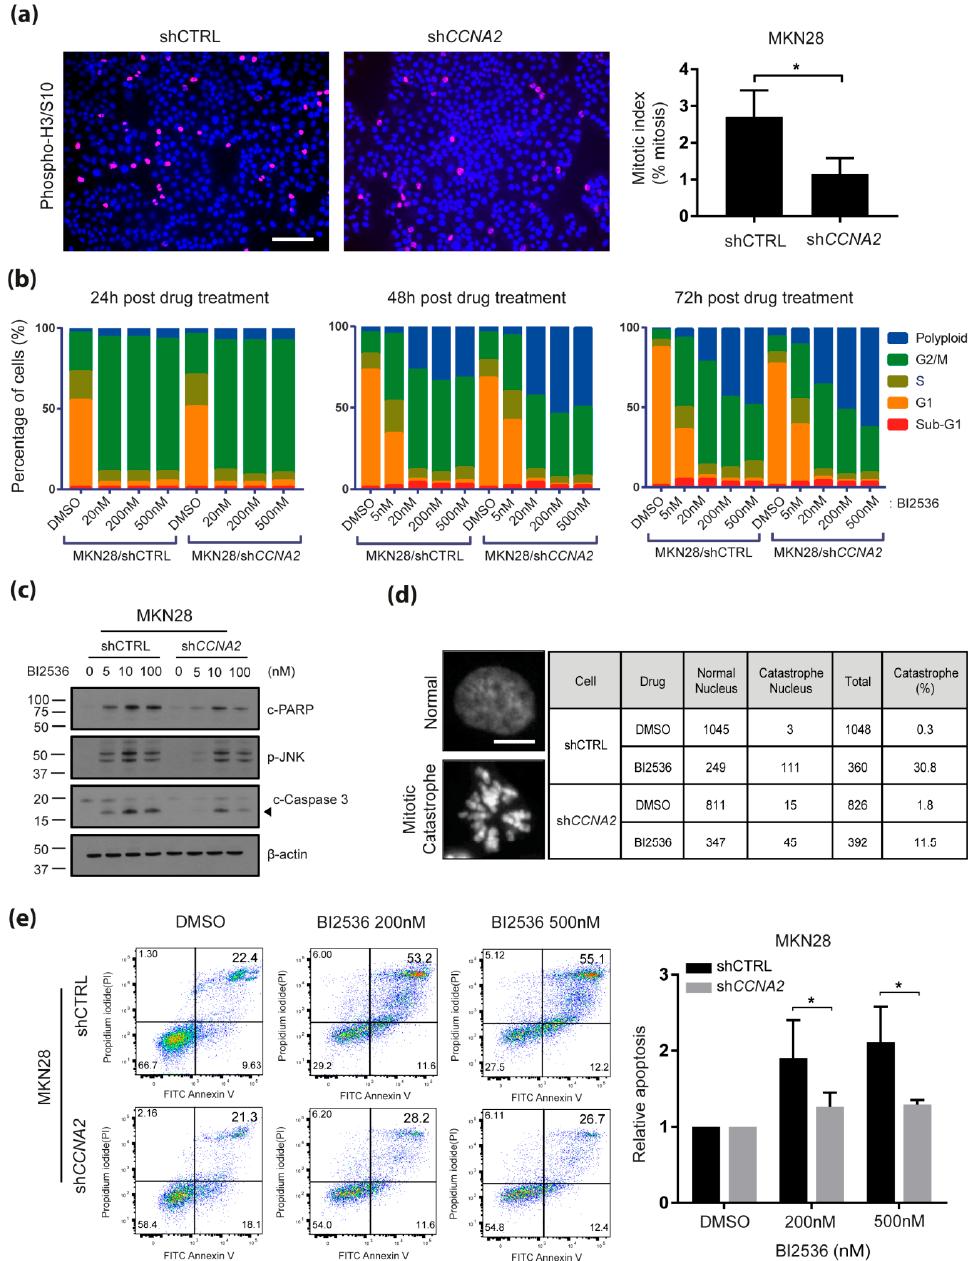
Figure 3. Elevated CCNA2 is required for BI-2536-induced mitotic catastrophe and apoptosis. ( a ) Mitotic cells were visualized by immunostaining using anti-phospho-Histone H3 antibody (red) in MKN28 cell lines expressing shCCNA2 or shCTRL (left). DAPI was counterstained to detect nuclei (blue). Scale bar: 200 µ m. Mitotic index (right), calculated by dividing the number of mitotic cells by the total number of cells. * p < 0.05; Student’s t- test; ( b ) evaluation of cell cycle by propidium iodide (PI) staining and flow cytometer analysis after BI-2536 treatment for the indicated time periods. Percentages of cells in each cell cycle are presented in bar plots; ( c ) effects of BI-2536 on the expression of apoptotic markers (e.g., cleaved PARP, phospho-JNK and cleaved caspase-3) 72 h post treatment. The amount of β -actin was measured as an internal control; ( d ) evaluation of mitotic catastrophe by DAPI staining and fluorescence microscopy (Axio Imager M2, ZEISS) at 72 h post BI-2536 (300 nM) treatment (Scale bar, 25 µ m); ( e ) apoptosis analysis using Annexin V-FITC / PI dual staining and flow cytometer analysis after BI-2536 (200 nM and 500 nM) treatment for 72 h are presented in both scatter plots (left) and bar plots (right). * p < 0.05; Wilcoxon rank-sum